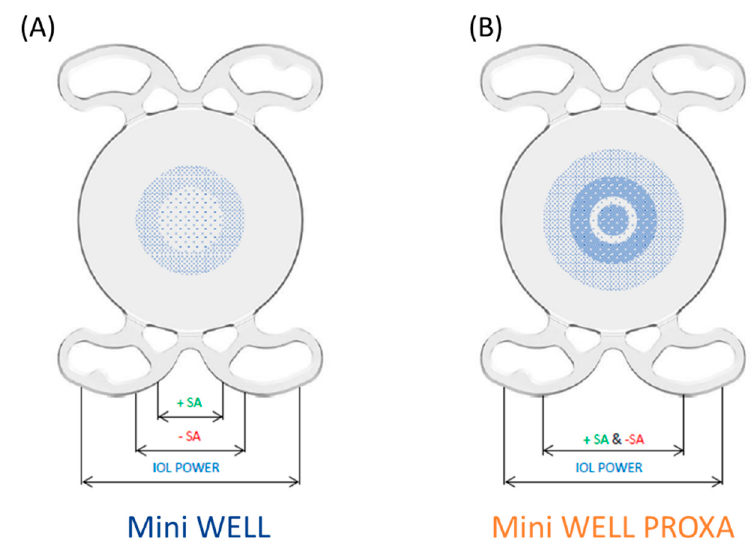
Figure 20. Optical design of ( A ) Mini WELL and ( B ) Mini WELL PROXA. (Courtesy of SIFI SpA).